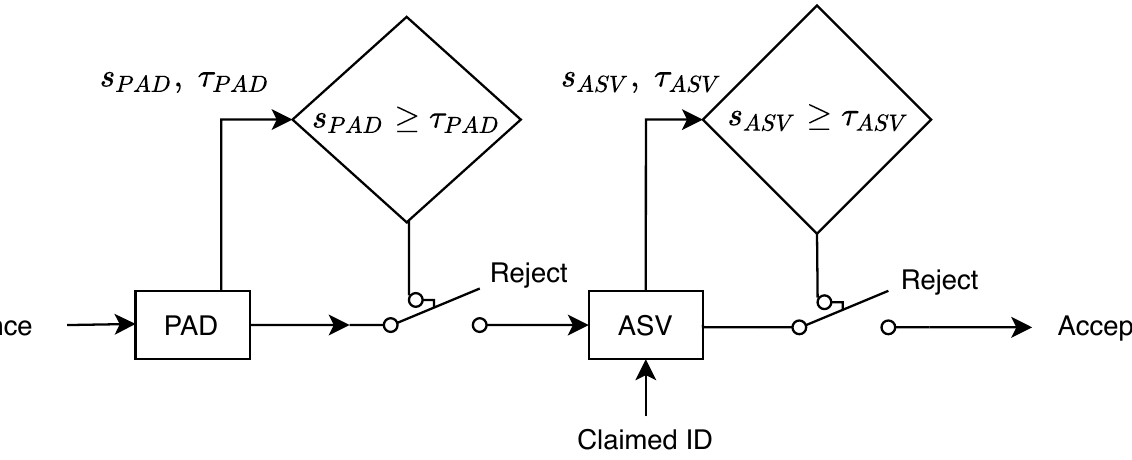
Figure 1. Block diagram of a cascade PAD + ASV voice biometric system based on score-level decisions. τ ASV , s ASV and τ PAD , s PAD are the ASV/PAD thresholds and